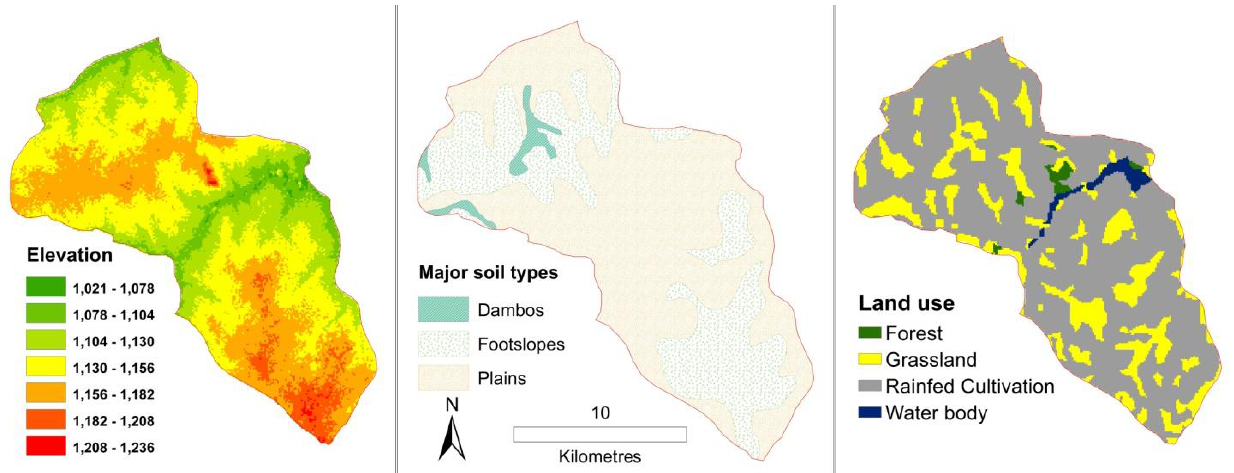
Figure 2. Biophysical characteristics and land use of Malingunde